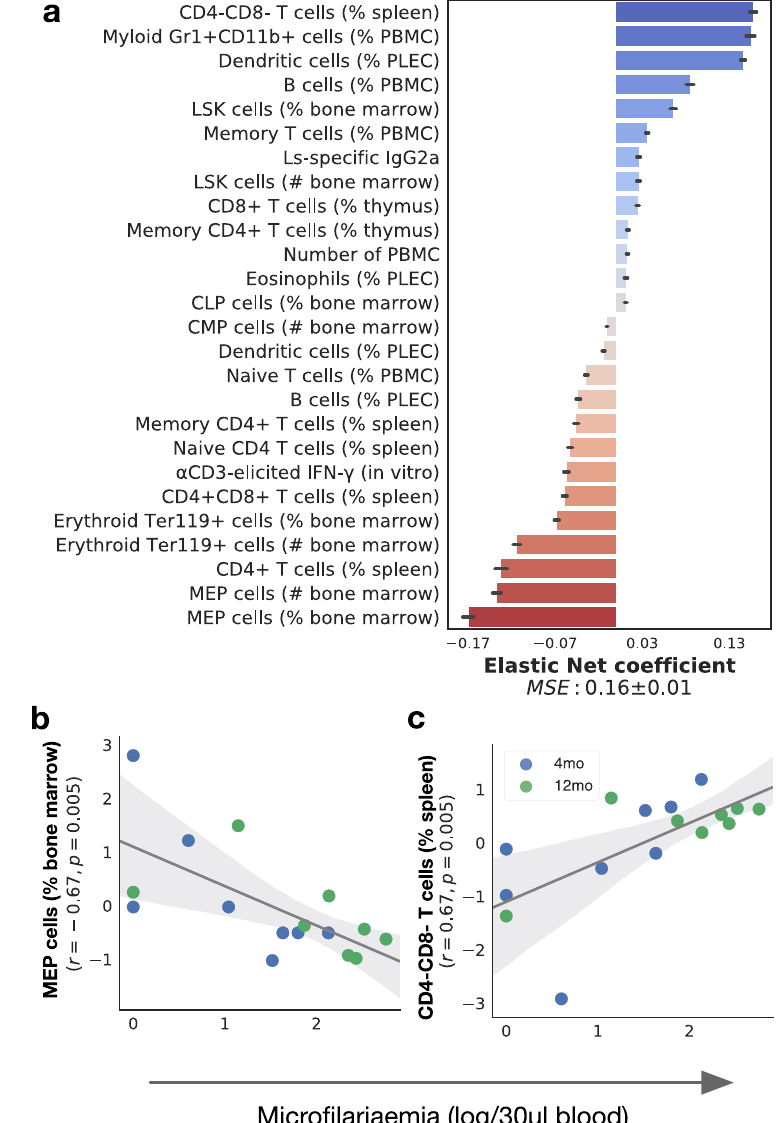
Figure 4. Microfilarial densities were positively correlated with the proportions of CD4-CD8- T cells in the spleen but negatively correlated with MEP cell proportions in the bone marrow. ( a ) The importance of each immune factor in predicting the density of blood-circulating microfilariae 2 months post infection in infected mice only (n = 16) was estimated using Elastic Nets, which achieved an average MSE of 0.16 ± 0.01 (see methods for details). Among the immune factors that best predicted microfilaraemia, those that were significantly correlated with microfilariaemia in isolation included the proportions of ( b ) MEP cells in the bone marrow (r = − 0.67; P = 0.005, GLM) and ( c ) the percentage of CD4 − CD8 − T cells in the spleen (r = 0.67; P = 0.005, GLM). Horizontal bars represent means and associated errors of the coefficients applied by the Elastic Net models trained on 10 repeated 75%/25% random splits of the full dataset. In regression plots, each point represents a mouse, the solid line is the robust regression (preferred over least squares to reduce the influence of outliers) and the shaded areas represent the corresponding 95% bootstrapped confidence